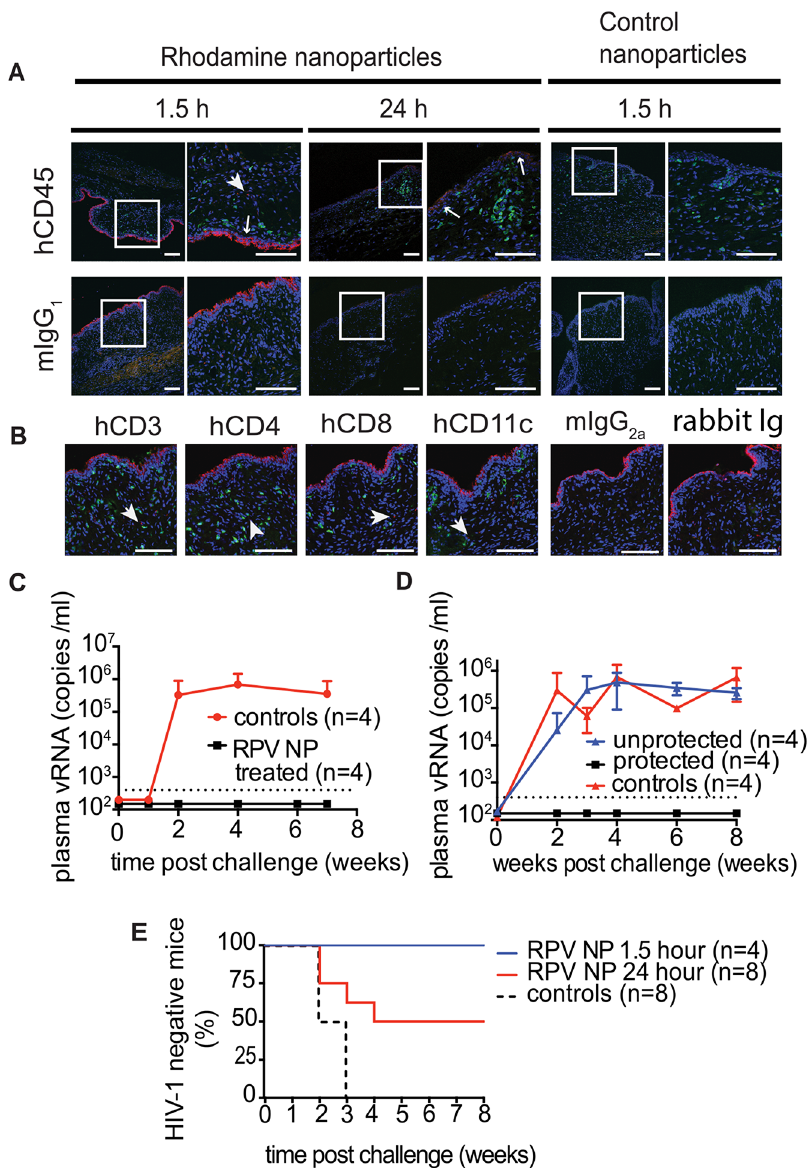
Fig 3. Distribution of rhodamine-labeled NPs in thermosensitive gel in the mouse female reproductive tract (FRT) and the ability of PLGA/RPV to offer pericoital protection against HIV-1 transmission. (A, B) Distribution of rhodamine-labeled PLGA nanoparticles in transverse sections of mouse FRT. Nanoparticles in thermosensitive gel were administered vaginally to humanized BLT mice. FRT was isolated and processed at indicated times and sections were stained for hCD45 (A), hCD3, hCD4, hCD8, hCD11c (B) and DAPI (A, B). Control nanoparticles contain only PLGA. Scale bar = 100 μ m. Arrowheads are showing nanoparticles in tissue, arrows are showing nanoparticles on the edge of vaginal epithelium. (C, D) Protection of BLT mice from vaginal HIV-1 infection by topically applied thermosensitive gel containing PLGA/RPV NPs (20 μ l of gel, 17.5 μ g of RPV per mouse). Controls were treated with vehicle or with thermosensitive gel containing blank NPs. Mice were exposed vaginally to HIV-1 RHPA 1.5 h (n = 4) (C) or 24 h (n = 8, two independent experiments) (D) after vaginal administration of gels. Viral RNA was quantified by real time PCR (RT PCR) with a limit of quantitation (LOQ) of 400 copies of RNA per ml (dotted line); graphs represent means ± SD. (E). Kaplan-Meier plots representing the percentage of BLT mice protected by PLGA/RPV NPs in thermosensitive gel over time until the first peripheral blood viral RNA detection. Protected animals were negative for viral RNA in plasma as well as viral DNA in tissue analyzed after necropsy. Statistical analysis: Log-rank (Mantel-Cox) test; controls vs. 1.5 h p = 0.0084, controls vs. 24 h p = 0.0582